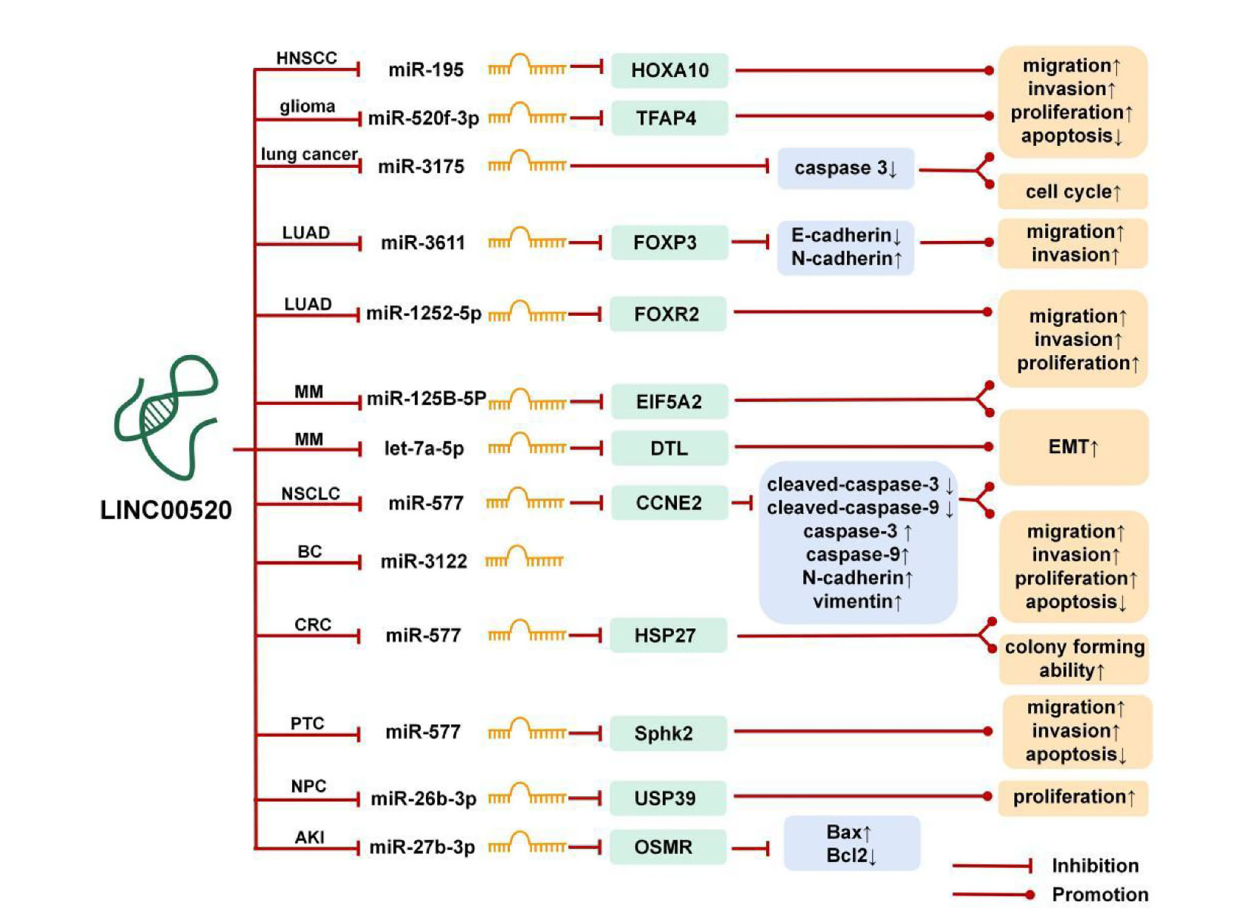
FIGURE 1 | The competing endogenous RNA (ceRNA) mechanism and potential downstream regulatory mechanisms of LINC00520. BC, breast cancer; PTC, papillary thyroid carcinoma; CRC, colorectal cancer; MM, melanoma; LUAD, lung adenocarcinoma; HNSCC, head and neck squamous cell carcinoma;